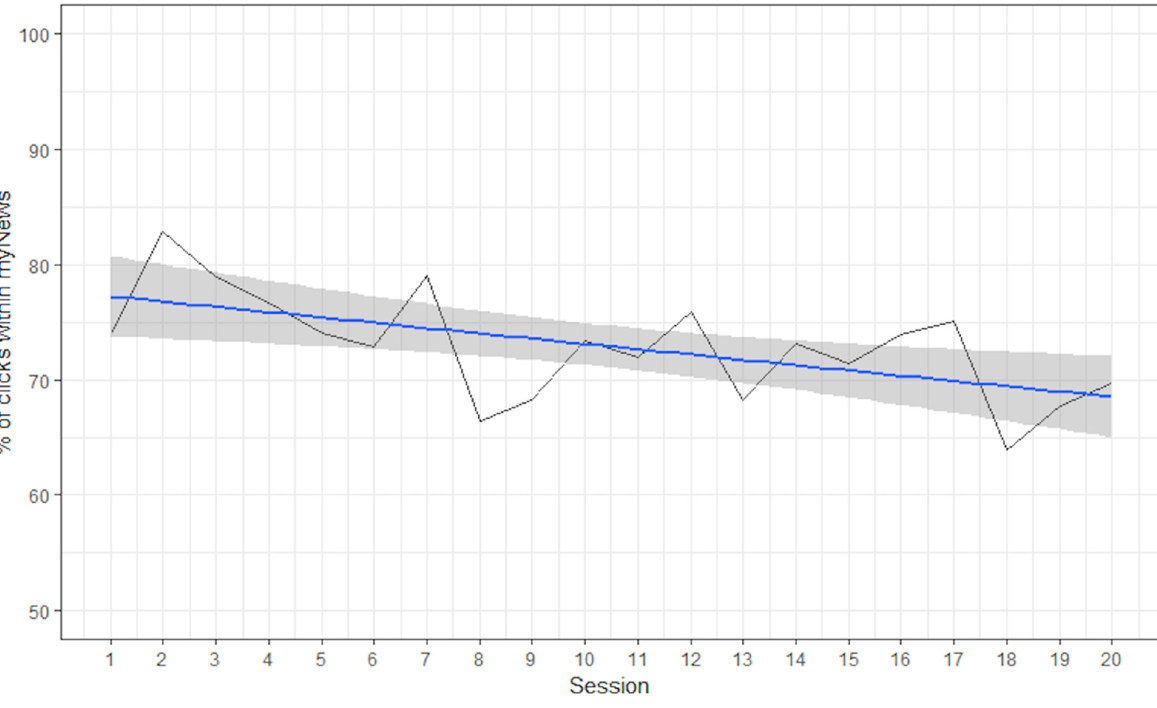
Figure 11. Percentage of clicks ordinary users performed within the MyNews area over time.